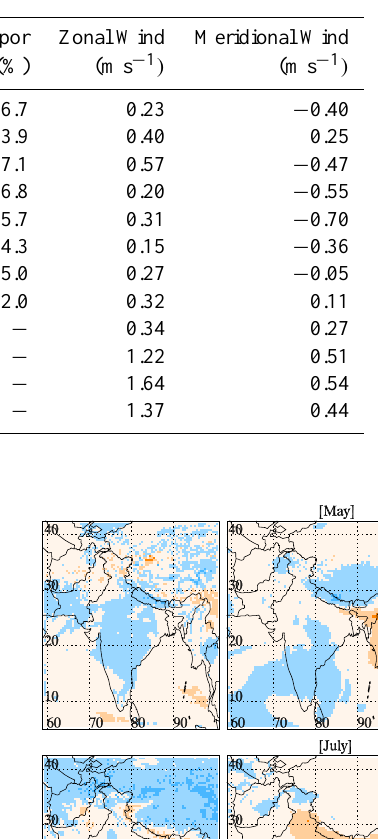
Table 9. Vertical profiles of mean bias in temperature, water vapor and wind components used to modify the initial and boundary conditions of these meteorological variables between 1000 and 100hPa for sensitivity simulations. Note that mean bias profiles for water vapor are estimated only up to 300hPa.